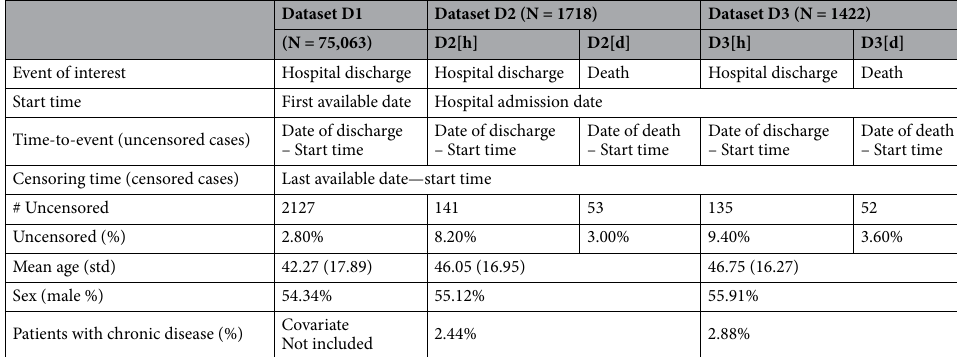
Table 1. Definition of time-to-event and censoring time for and patient characteristics included in Datasets D1, D2 and D3. For each patient in D2 (resp., D3), we also include longitude and latitude (resp., longitude, latitude, population density and gross domestic product) information as well. Last available date for a patient is the most recent date among his/her symptom onset date, hospital admission date, COVID-19 confirmation date, date of event (hospital discharge or